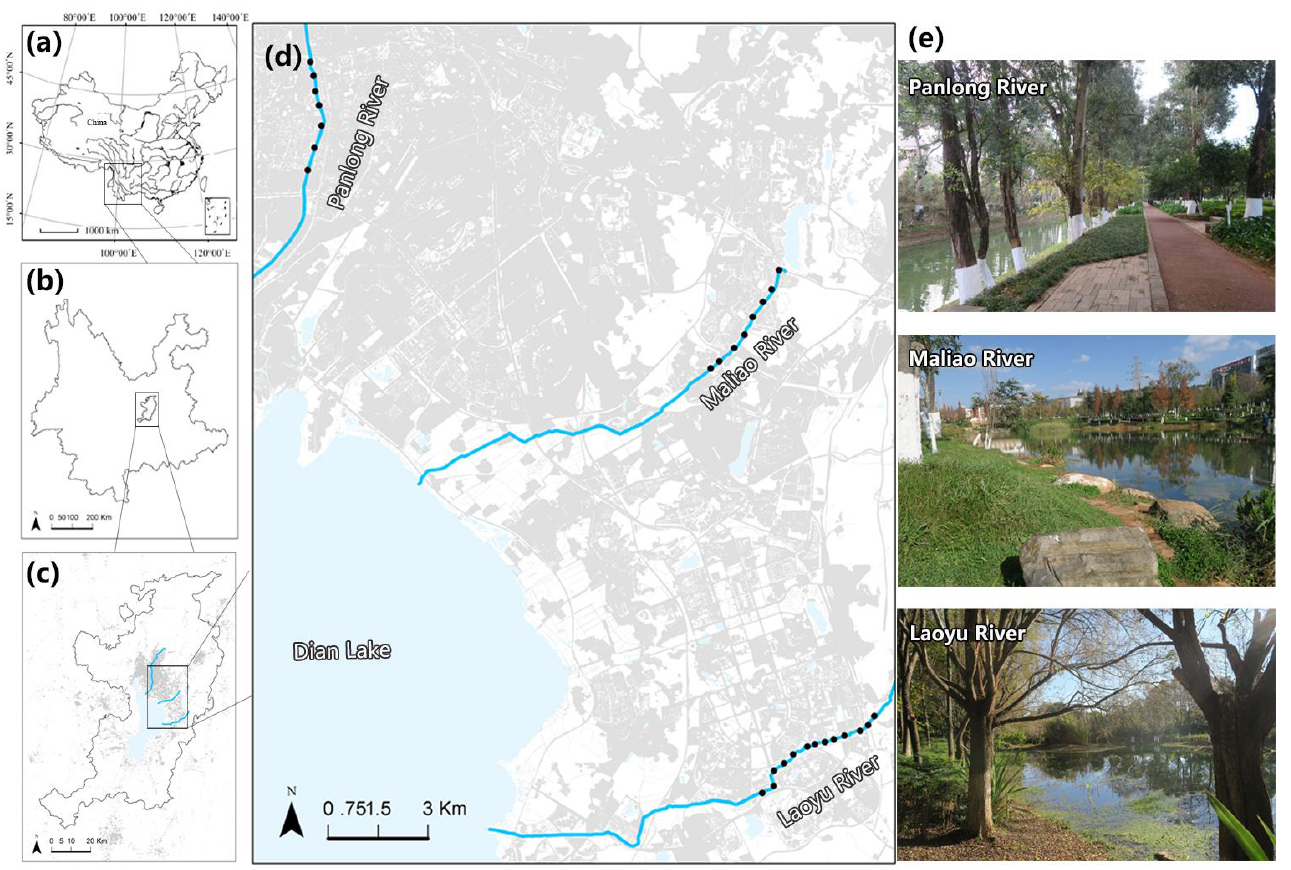
Figure 1. Location of the 28 sampling sites among three rivers with different levels of human dis- turbance along the urban development gradient in Kunming, Yunnan Province, China (the Panlong River—high-human disturbance rivers; the Maliao River—medium-human disturbance rivers; the Laoyu River—low-human disturbance rivers). ( a ) The location of Yunnan Province in China. ( b ) The location of the main urban area (the six administrative districts) of Kunming surrounding Dianchi Lake. ( c ) The three rivers with different levels of human disturbance along the urban development gradient in Kunming. ( d ) The location of the 28 sampling sites. The sampling sites we selected were located in the typical green space along each river. ( e ) Pictures of the typical habitat types in each river. Table 1. List of landscape- and patch-level variables assessed for each sampling site in three urban rivers at the 500, 100, and 20 m